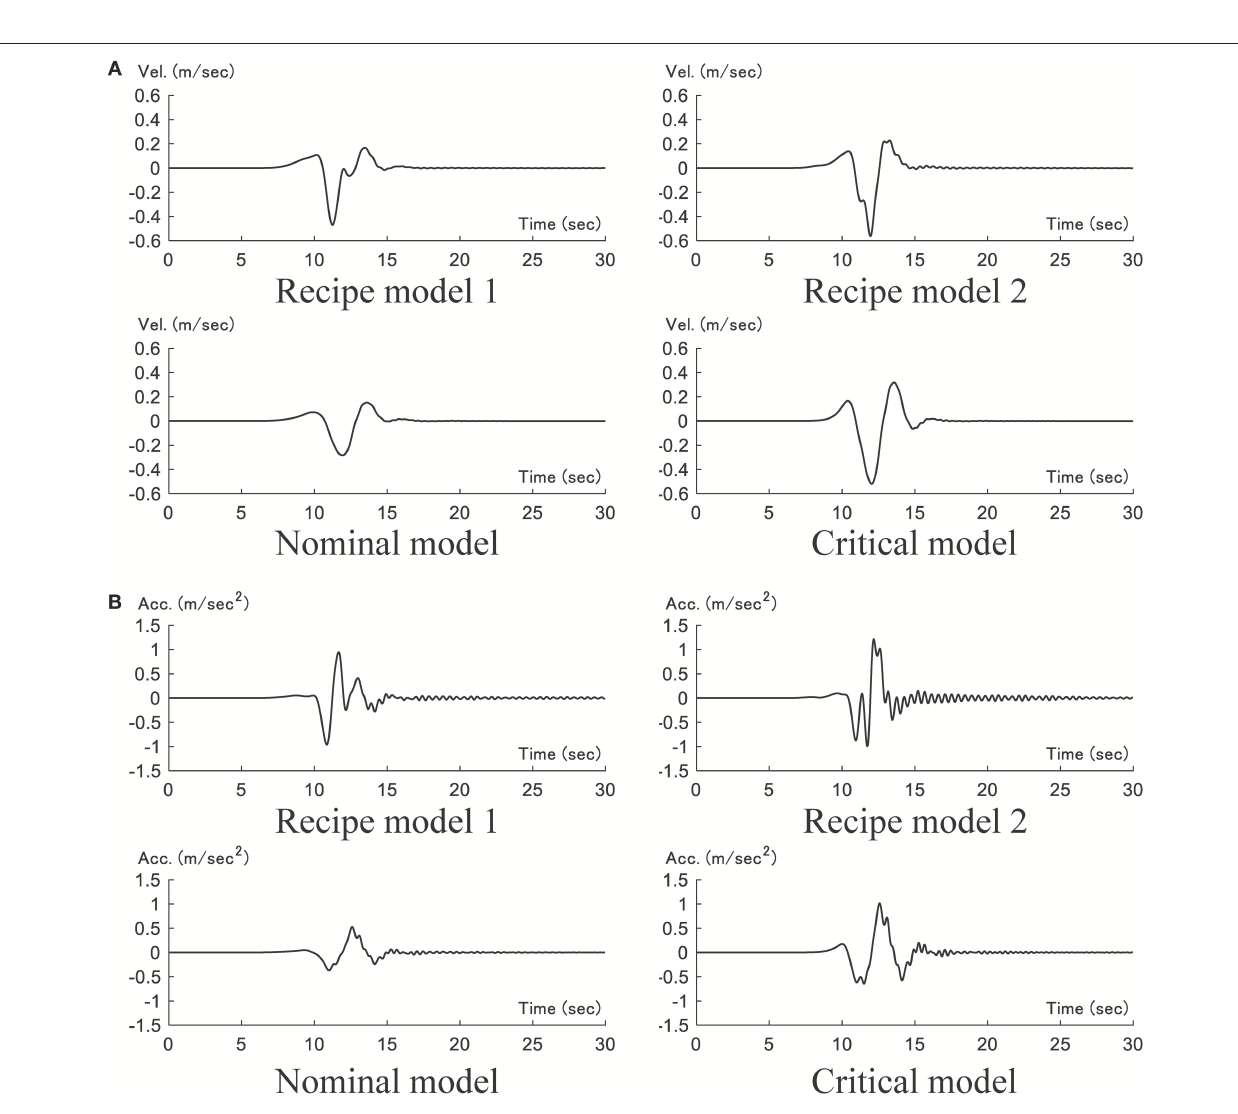
Frontiers in Built Environment |